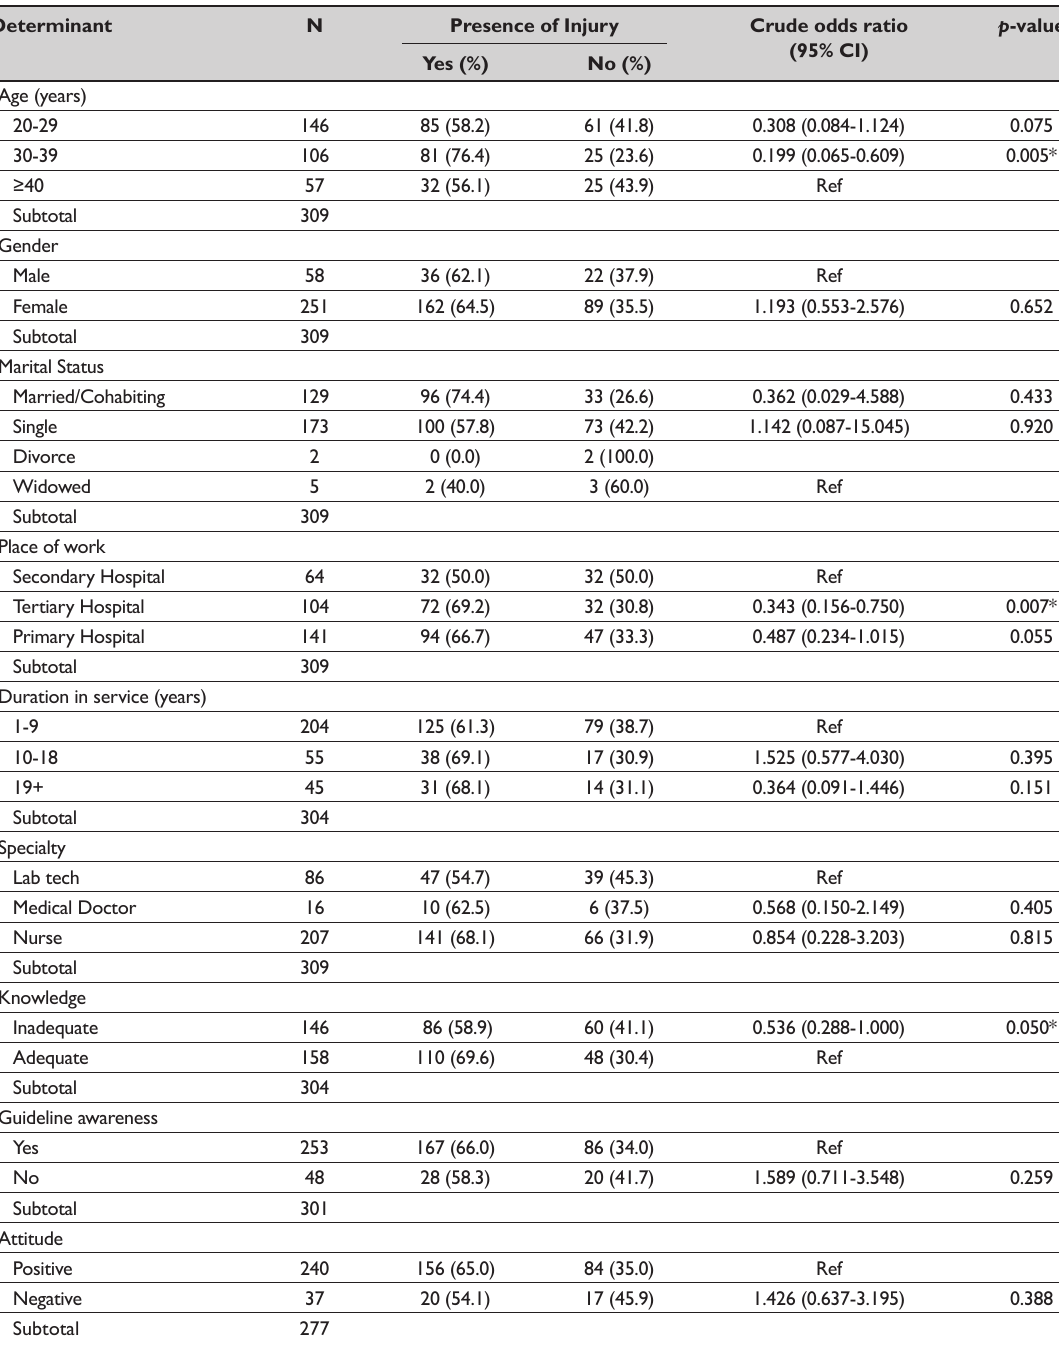
Table 2: Determinants of occupational exposure to HIV Determinant N Presence of Injury Crude odds ratio